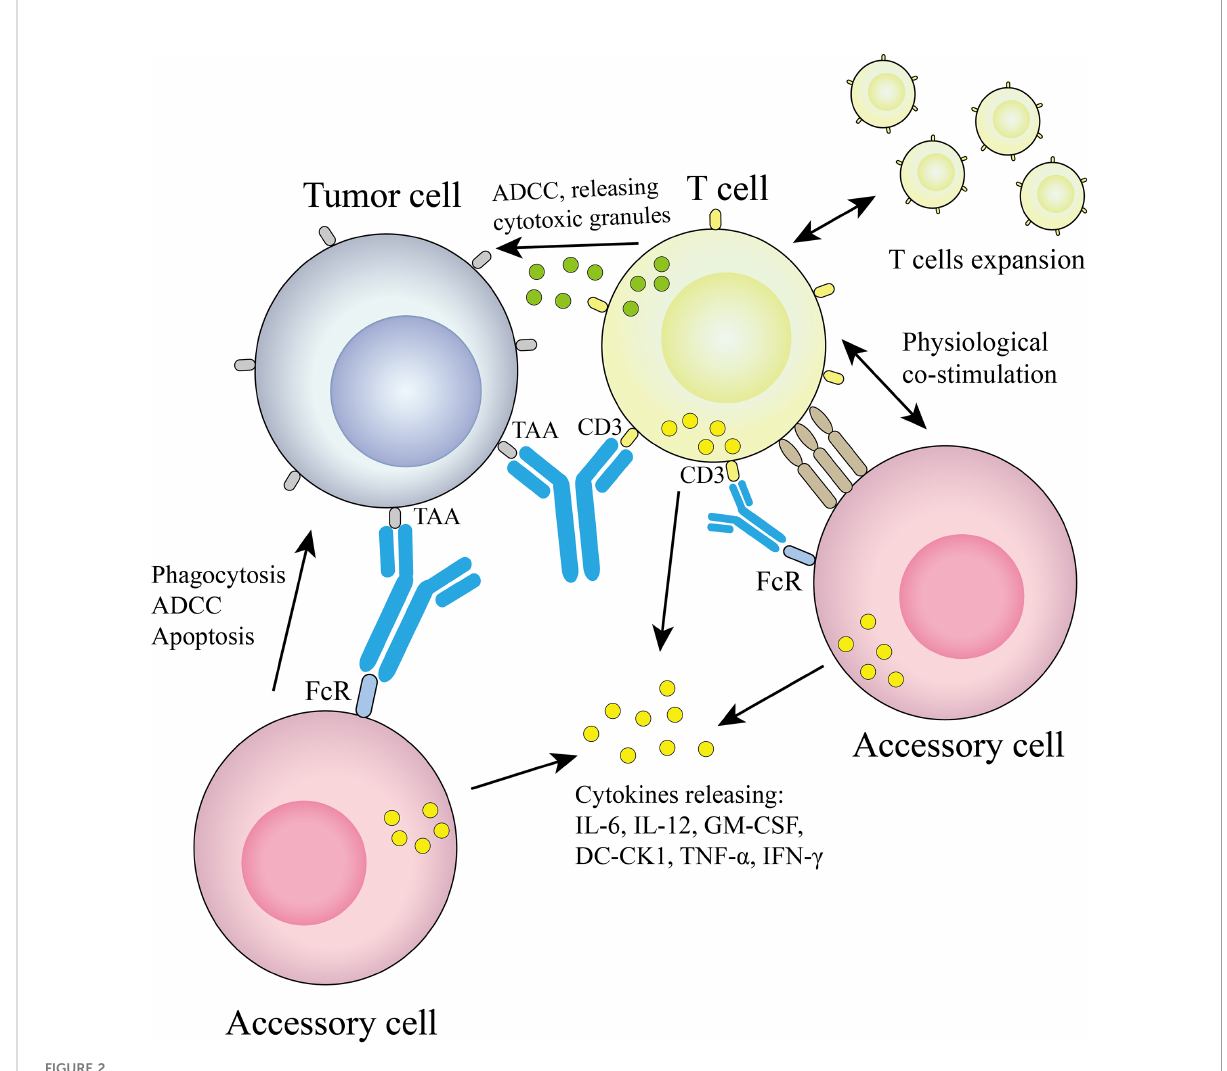
FIGURE 2 Triomab antibodies redirect T cells and other accessory cells to a tumor